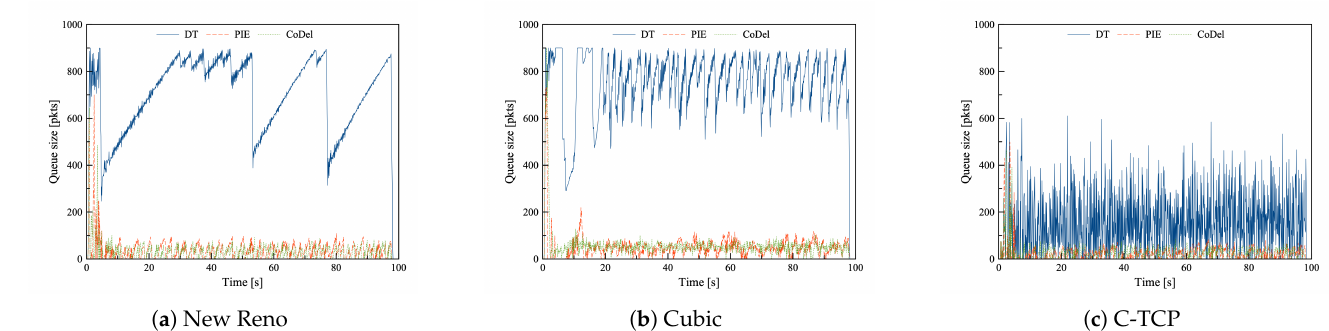
Figure 5. The queue length of DT, PIE and CoDel in combination with ( a ) New Reno, ( b ) Cubic, and ( c ) C-TCP in the Access Link scenario with common TCPs in uncongested network.